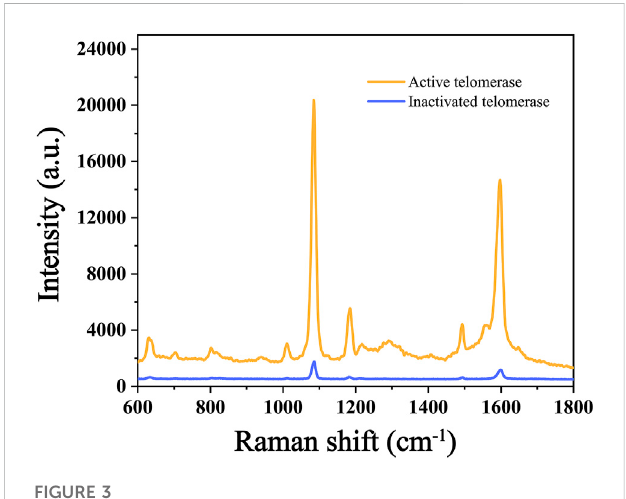
FIGURE 3 Raman intensity of the control test (active telomerase and inactivated